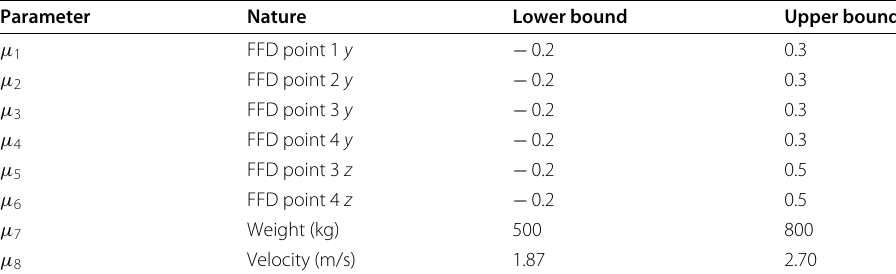
Table1 Design space (FFD lattice 2 × 2 × 2 ) with eight design parameters